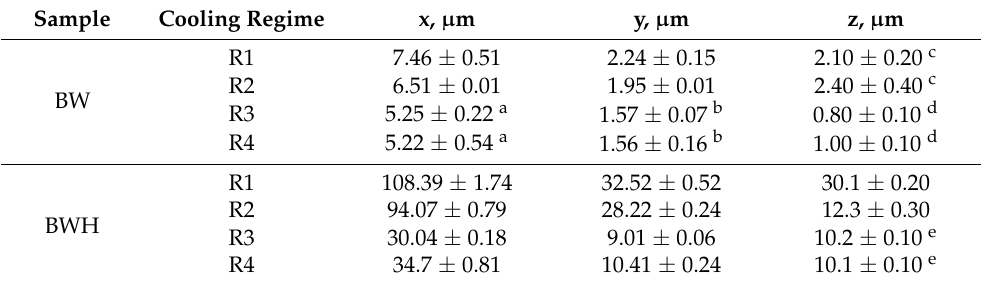
Table 1. Crystal size parameters for beeswax and beeswax hydrocarbons based oleogels.